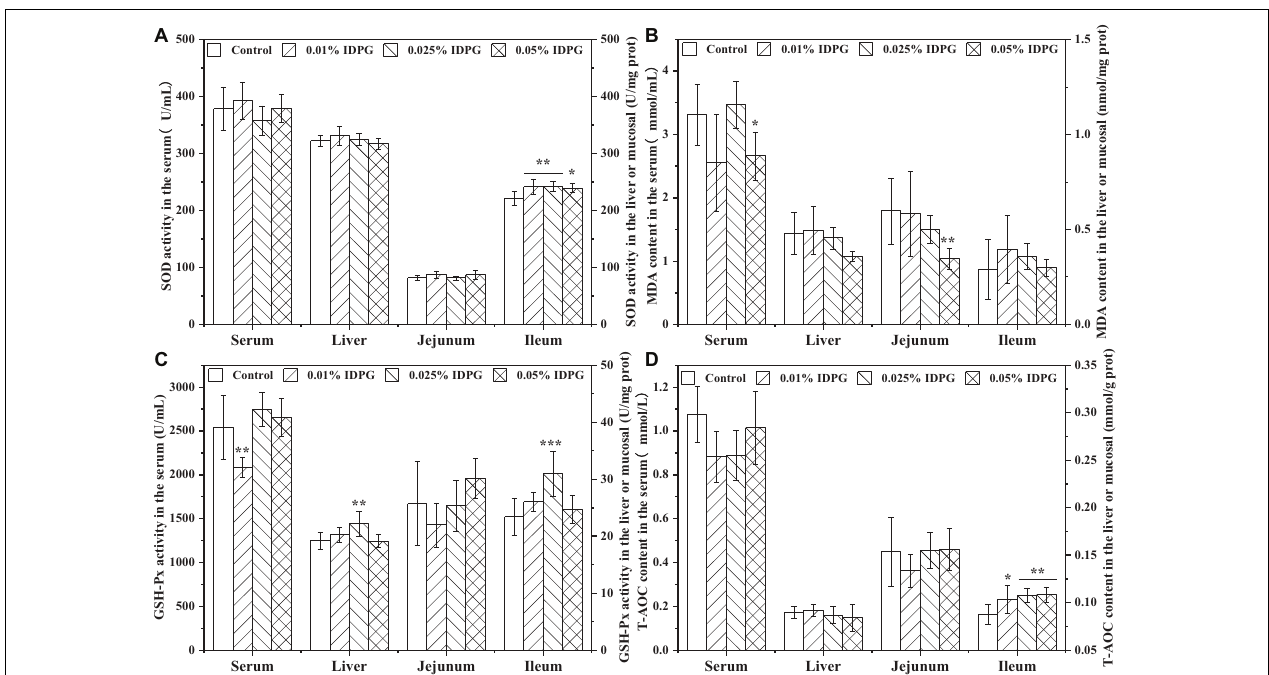
FIGURE 4 | Antioxidants and malondialdehyde in different organs of laying hens fed diets supplemented with incomplete degradation products of galactomannan (IDPG). * P < 0.05, ** P < 0.01, and *** P < 0.001 compared with control group in each tissue. (A) Superoxide dismutase (SOD); (B) Malondialdehyde (MDA); (C) Glutathione peroxidase (GSH-Px); (D) Total antioxidant capacity (T-AOC).